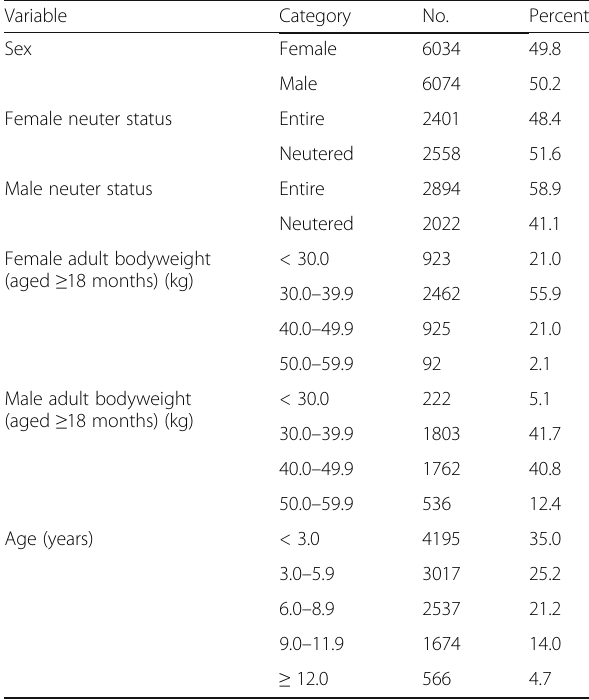
Table 1 Demography of German Shepherd Dogs under primary veterinary care at practices participating in the VetCompass TM Programme in the UK from January 1st, 2013 to December 31st, 2013